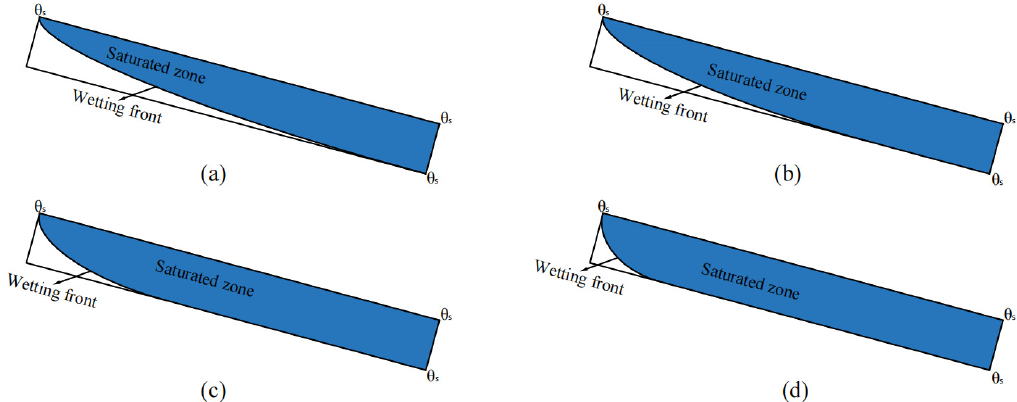
Figure 4. The scheme of the movement of wetting front profile. ( a – d ), the wetting front migrates migrates upslope.